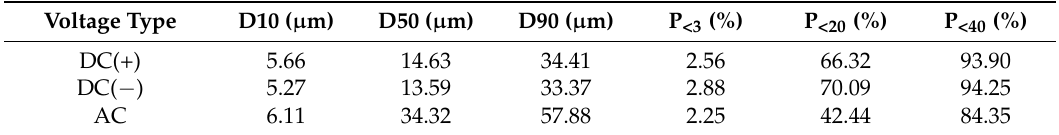
Table 3. Particle size of the